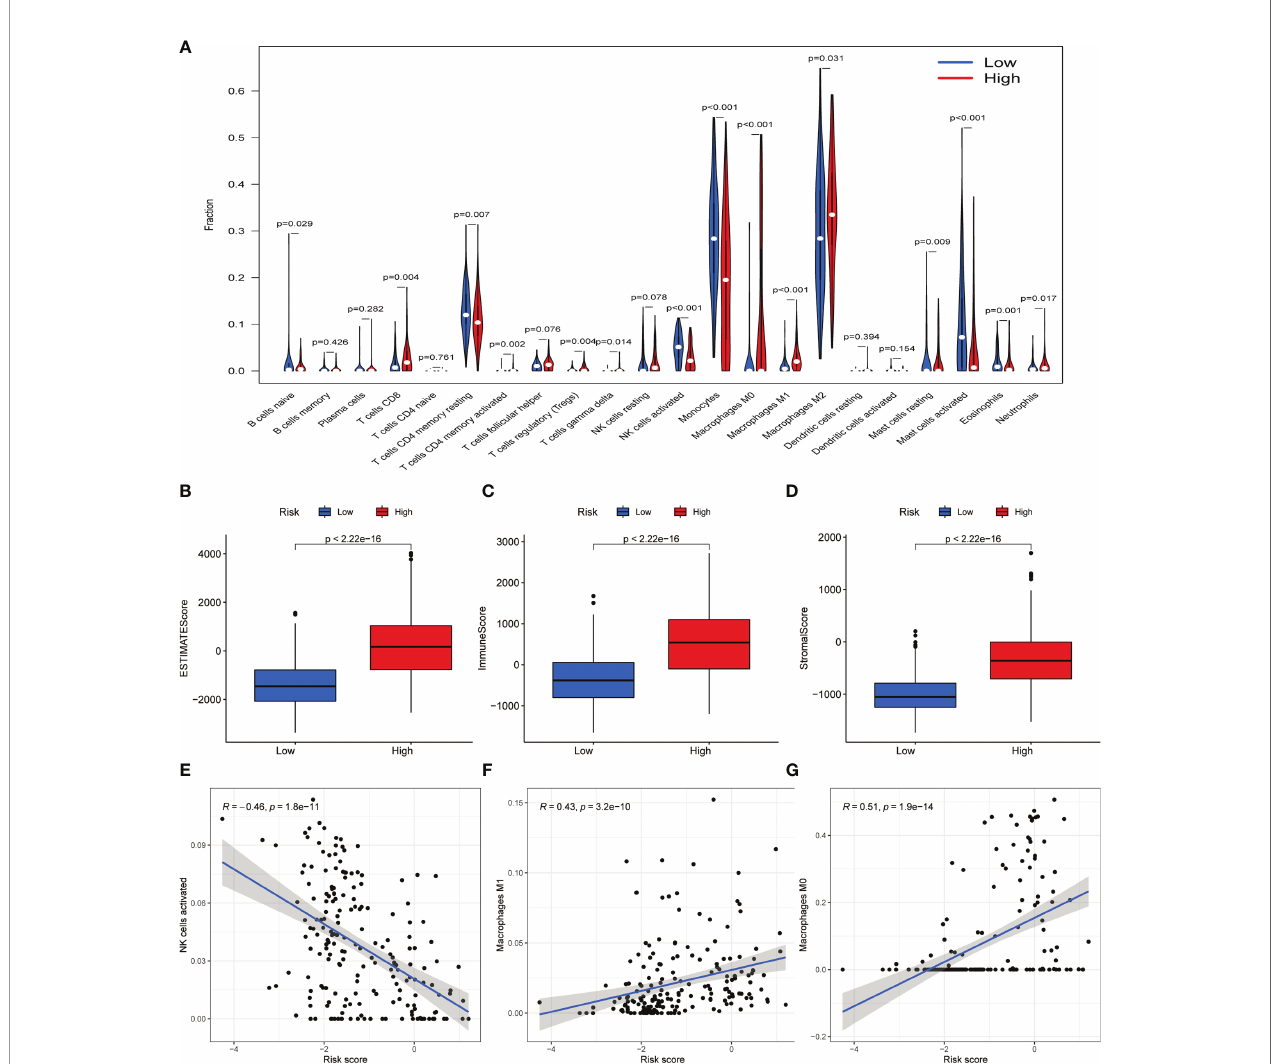
FIGURE 7 | Immune fi ltration analysis between high- and low-risk groups. (A) Differential analysis of immune-related cells based on risk score. (B – D) Boxplot showed the comparisons of Estimation, immune and stromal score between high- and low-risk groups. (E – G) Scatter plot showed that the correlations of risk score with NK cells activated, Macrophages M1 and Macrophages